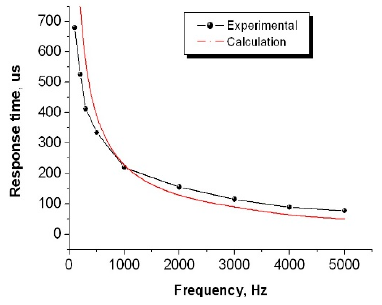
Figure 12. Frequency dependence of response time in DHF regime [38].